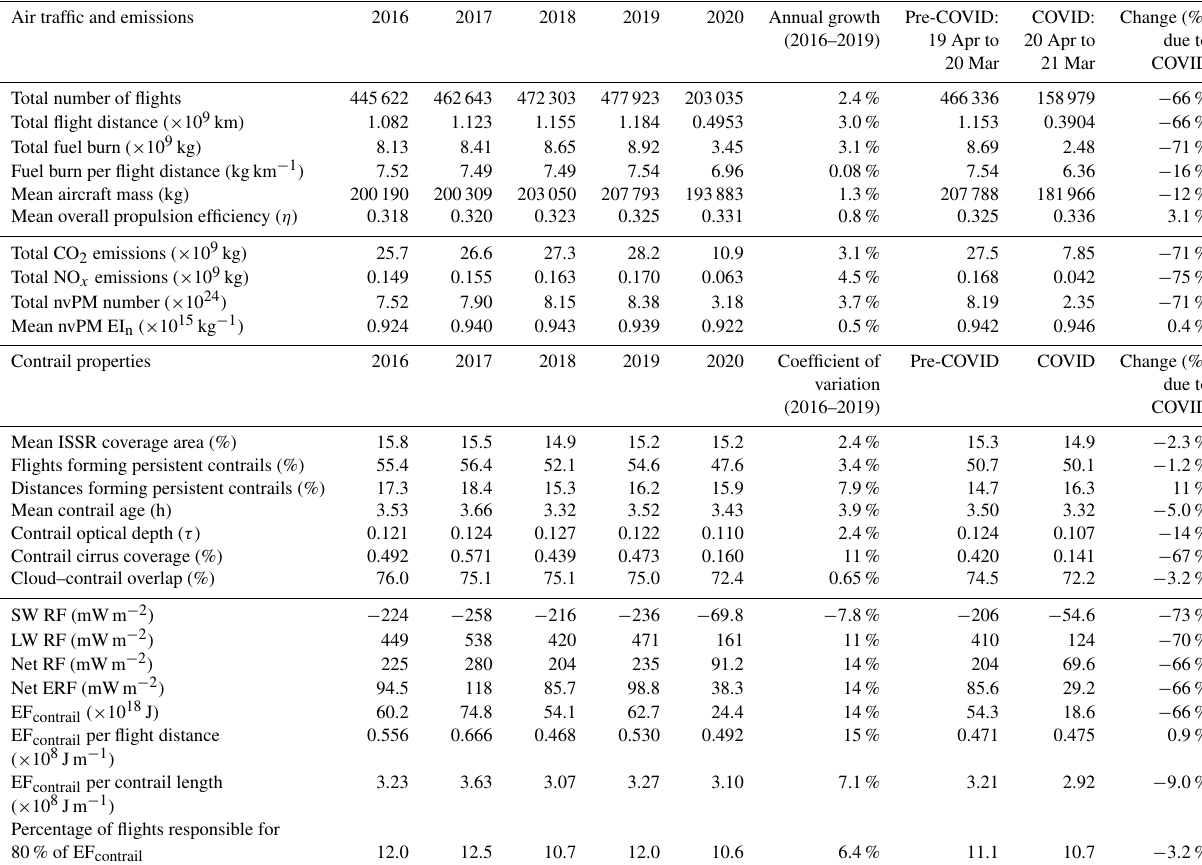
Table 1. Annual air traffic, emissions, meteorology and contrail statistics in the North Atlantic flight corridor from January 2016 to March